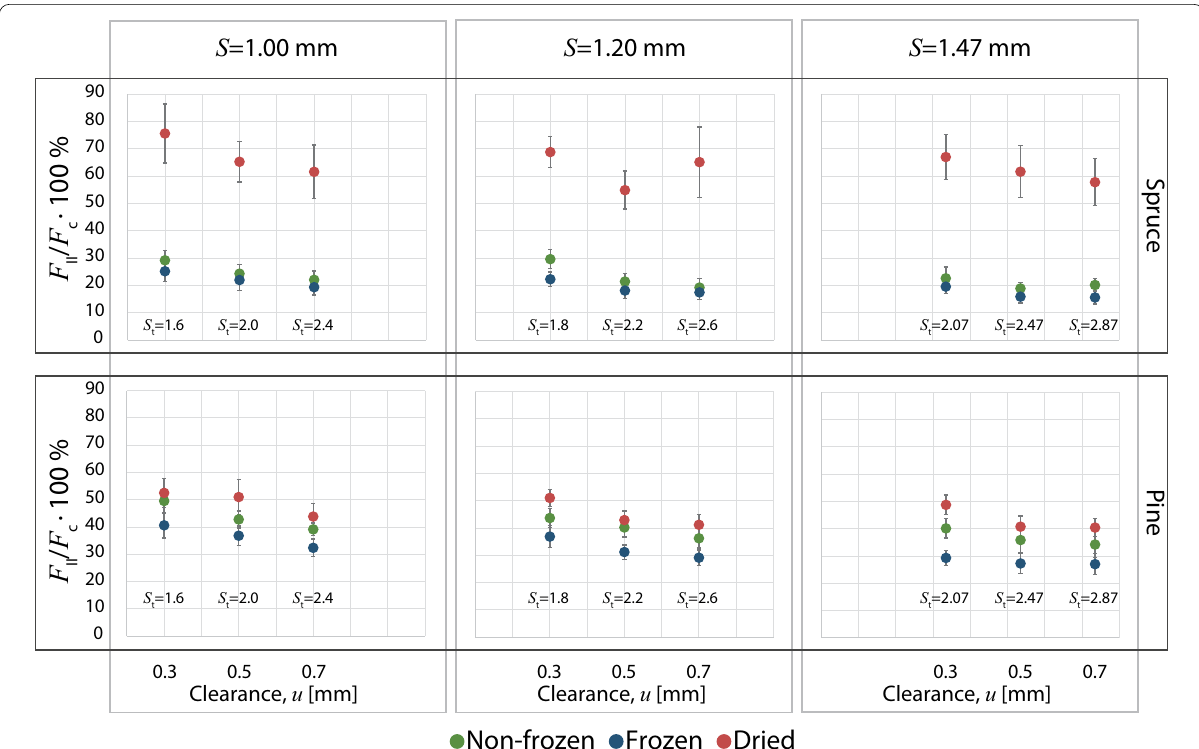
Fig. 11 The Zone II force contribution to the cutting force for different band thicknesses ( S = 1.47 , 1.20 and 1.00 mm) as the clearance is reduced ( u = 0.7 , 0.5 and 0.3